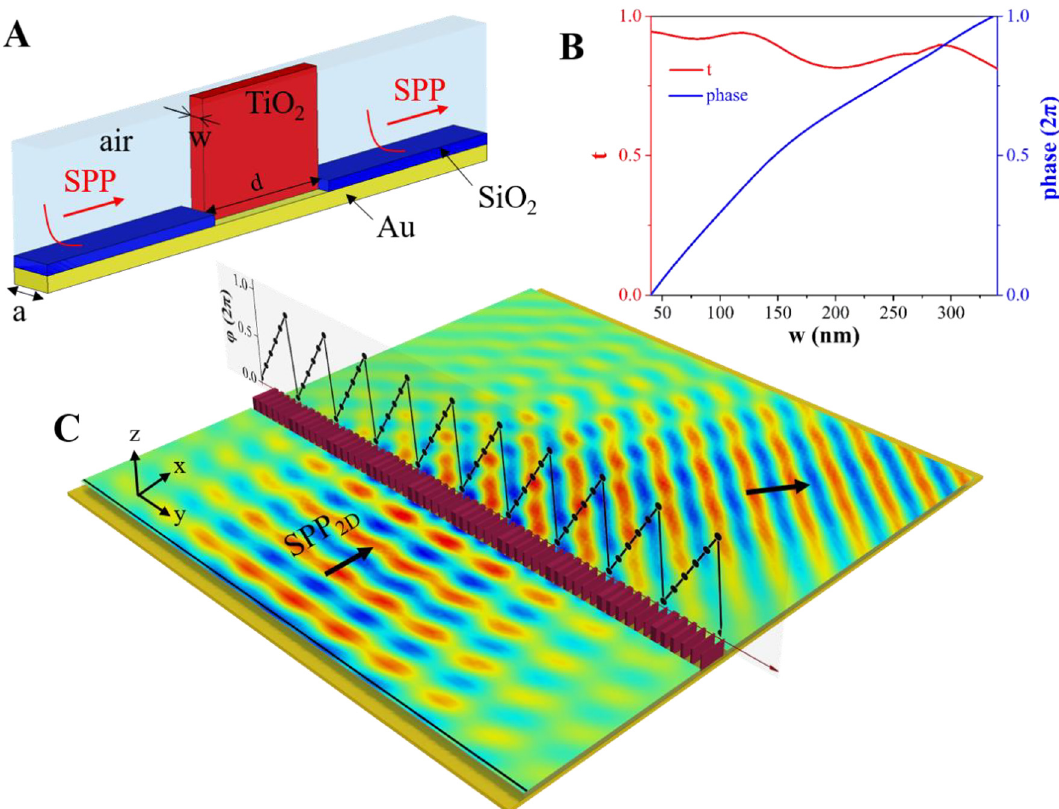
Figure 2: Unit cell design and demonstration of meta-wall. (A) Simulation setup to obtain the SPP transmission coefficient of a non-gradient meta-wall composed of a TiO 2 slab ( d = 1.4 μ m, a = 400 nm). By changing the width w of the meta-wall, the transmission phase of SPP can be modulatedfreely.(B)FEM-simulatedtransmissionamplitudeandphaseofSPPversusthewidth w .(C)FEM-simulatednear- fi eld E z patternona planeabovetheplasmonicmetalforaSPPGaussianbeamstrikingthemeta-wallatnormalincidence.Here,thewdistributionofthemeta-wall is designed to satisfy a phase gradient ξ = 0.62 k 2 DSPP